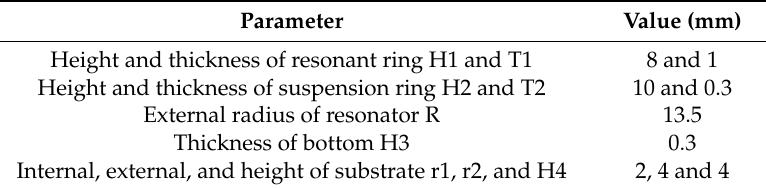
Table 2. Geometry parameters of the resonator.